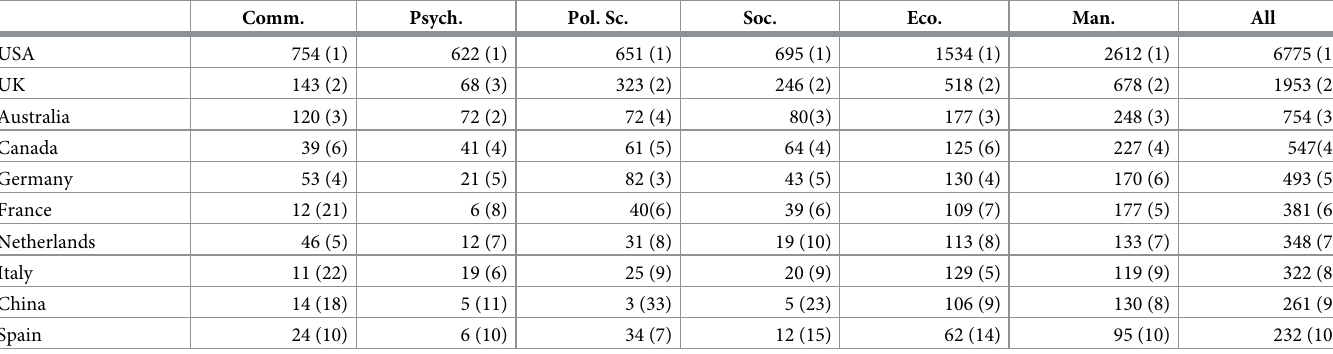
Table 6. Geographic representation of EBs for each field and for the overall network. Comm.